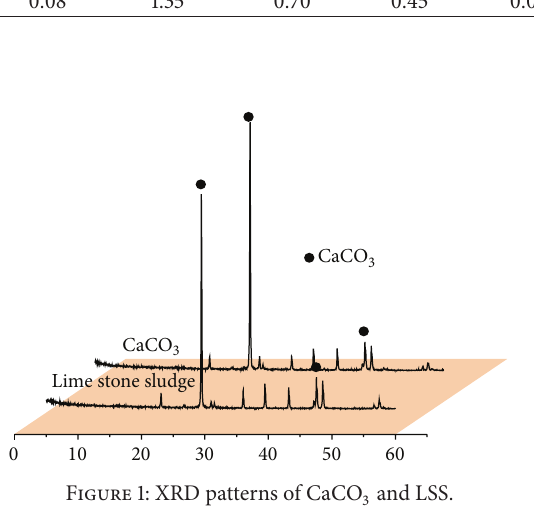
Figure 1: XRD patterns of CaCO 3 and LSS.